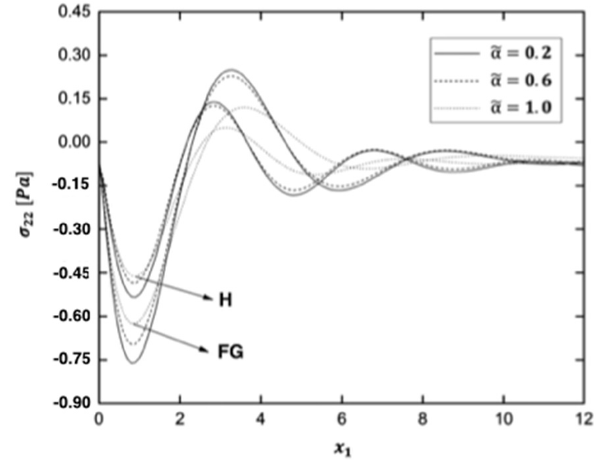
Figure 5. Variation of the thermal stress wave 𝜎 (cid:2869)(cid:2871) along 𝑥 (cid:2869) – axis in the functionally graded (FG) and homogeneous (H) anisotropic fiber-reinforced plates under different fractional order parame- ters.